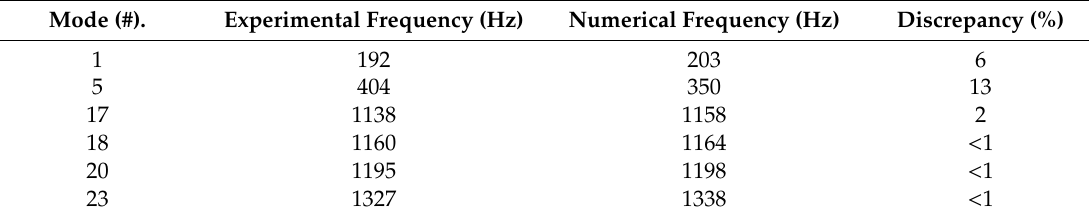
Table 8. Comparison of experimental and numerical frequencies for the resonant modes. Mode